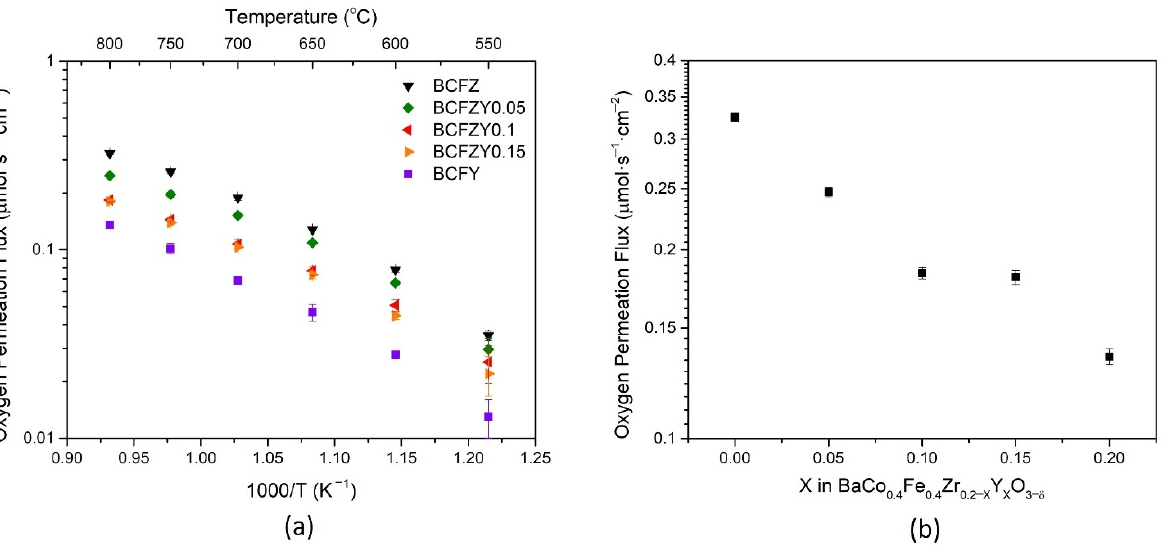
Figure 3. Oxygen permeation flux normalized for 1 mm BCFZY X pellets as a function of ( a ) temperature, and ( b ) Y stoi- chiometry at 800 °C.